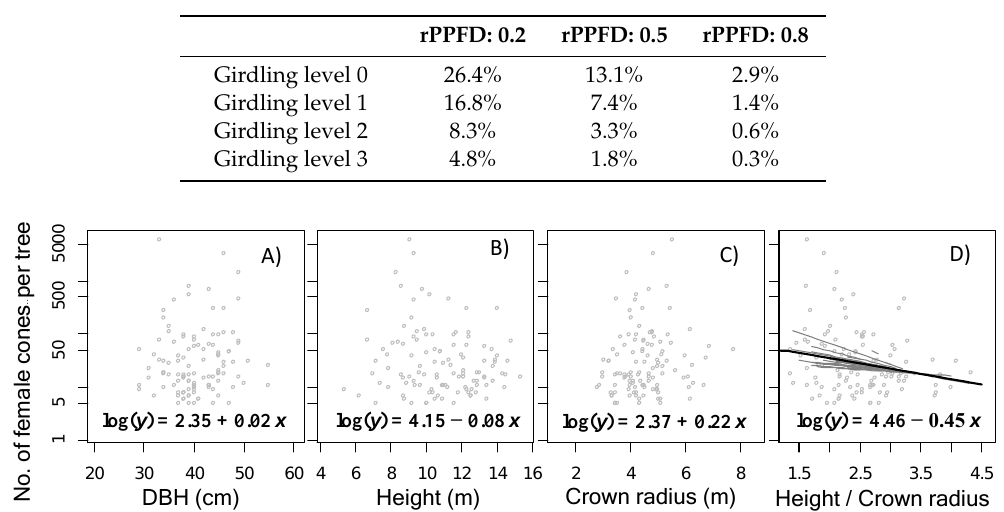
Figure 4. Relationship between number of female cones per tree and ( A ) tree diameter, ( B ) tree height, ( C ) crown radius and ( D ) height / crown radius ratio. In panel D, the thick black line indicates a significant regression relationship across all genotypes ( p < 0.05), while gray lines indicate relationships for each genotype. There were no significant relationships between female cone production and the other traits ( A – C ).